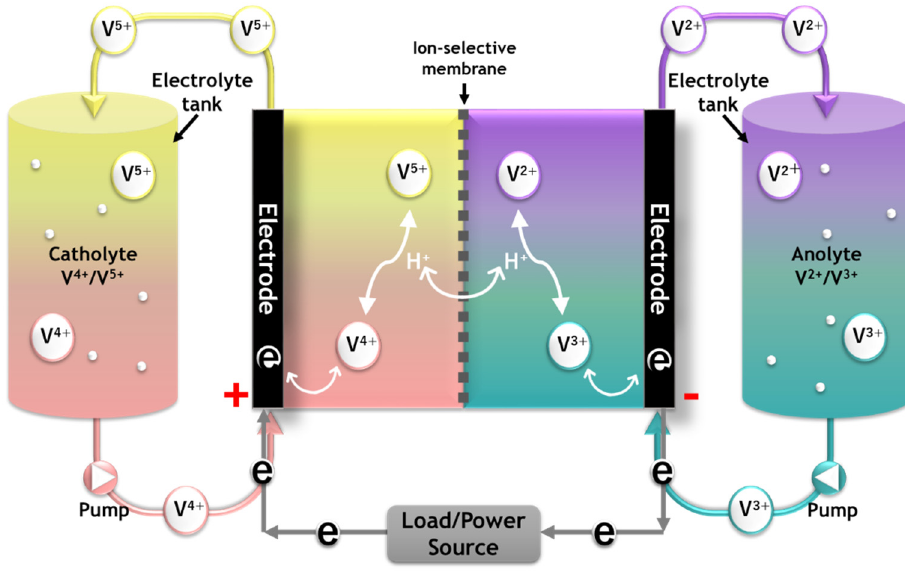
Figure 1. Schematic diagram of a VRFB system showing the working principle. Meanwhile, the membrane is one of the most important components that determine the charge–discharge performance and durability of all kinds of RFB systems [9]. Although it depends on the type of redox couples, RFBs mainly employ ion-exchange membranes (IEMs) that prevent the mixing of electrolytes between the anode and cathode compart- ments and act as an ion conductor [2,5]. The IEMs used in the RFB system require low electrical resistance, high selective permeability for specific ions, low diffusion coefficient for solvents, and excellent chemical and mechanical stabilities [10]. Considering the charac- teristics of the VRFB system operated under strongly acidic conditions, the IEMs should also have high acid and oxidation resistance and excellent selective permeability to hy- drogen ions compared with vanadium cations [10,11]. From this point of view, Nafion, a perfluorinated cation-exchange membrane (CEM), has been widely utilized as a separa- tion membrane in VRFB systems, but it is suffering from some drawbacks, such as high membrane cost and significant vanadium crossover. As an alternative, therefore, the use of anion-exchange membranes (AEMs) has recently attracted attention, and hydrocarbon- based IEMs are being actively developed to lower the expensive membrane cost [12,13]. However, in the case of hydrocarbon-based IEMs, despite their excellent electrochemical characteristics, they are difficult to apply to practical systems due to their poor chemical sta- bility, so research on this is urgently needed [2,10,14,15]. In addition, a partially fluorinated IEM can be considered to improve the chemical stability and reduce the manufacturing cost of the IEMs